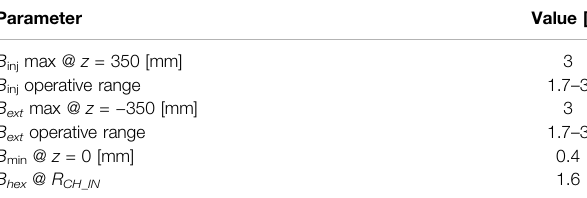
TABLE 1 | PANDORA magnetic fi eld speci fi cations and operative